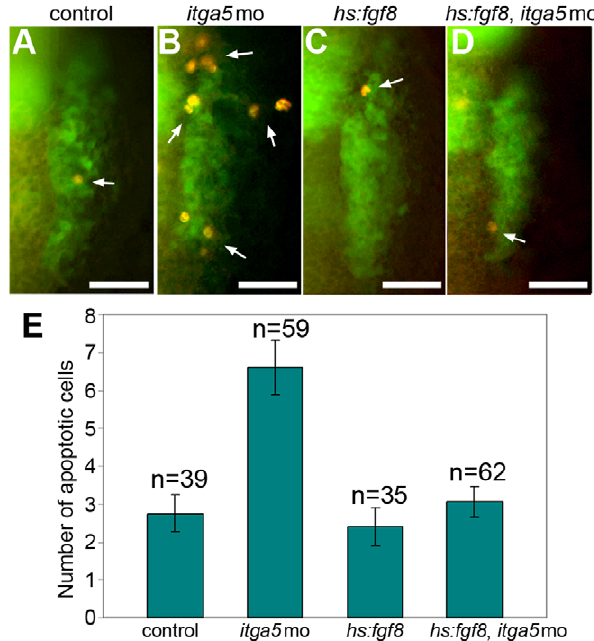
Figure 6. Elevated cell death in itga5 morphants is rescued by hs:fgf8 . ( A–D ) Transgenic pax2a:GFP embryos immunostained for GFP (green) and Caspase3 (red). Images show dorsal views (anterior up) of the right otic/epibranchial domain in a control embryo (A), itga5 morphant (B), hs:fgf8/ + embryo (C) and hs:fgf8/ + embryo injected with itga5 -MO (D). White arrows mark apoptotic cells. All embryos were heat shocked at 39 u C for 30 minutes beginning at 11.5hpf and fixed at 13.5 hpf. Scale bar, 50 m m. ( E ) Mean number of Caspase3-positive cells in the otic/epibranchial domain in each of the four groups of embryos. Error bars indicate S.E.M.